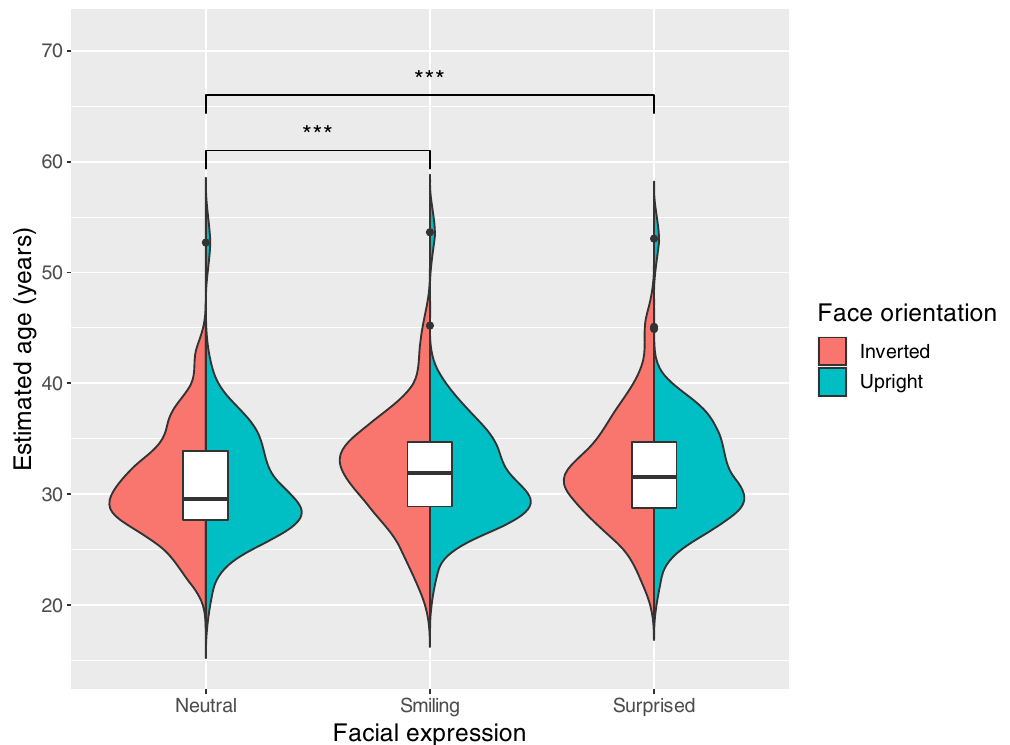
Figure 1. Violin and box plots show the mean estimated age distribution for each expression by facial orientation. The black dots represent the outliers for each facial expression. p < 0.001 =